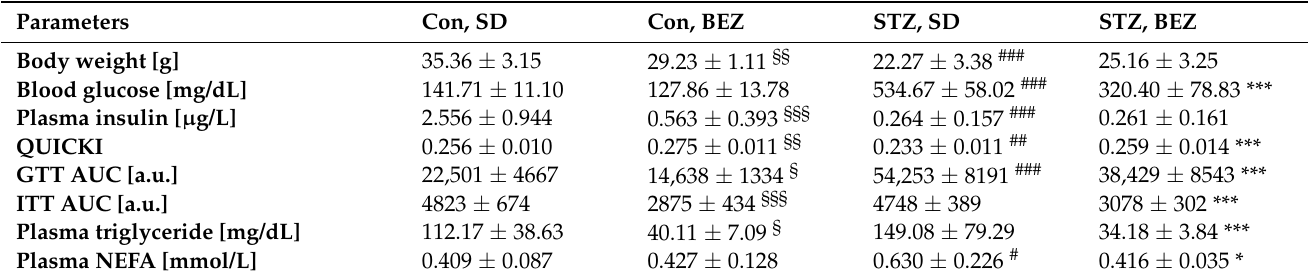
Table 1. Metabolic parameters of BEZ-treated STZ